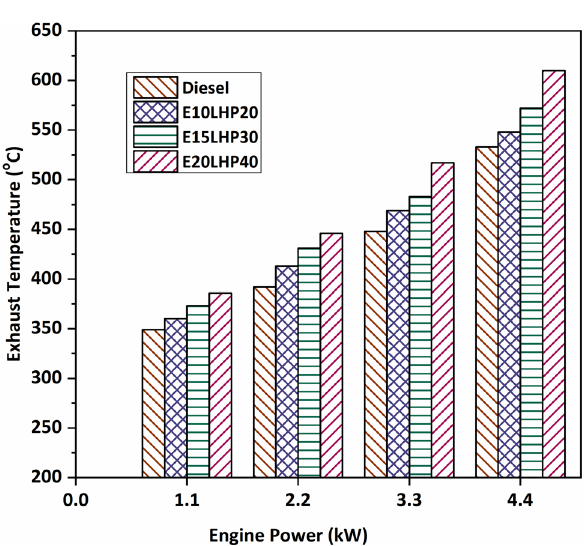
Figure 4. Impact of Exhaust gas temperature on LHP and ethanol